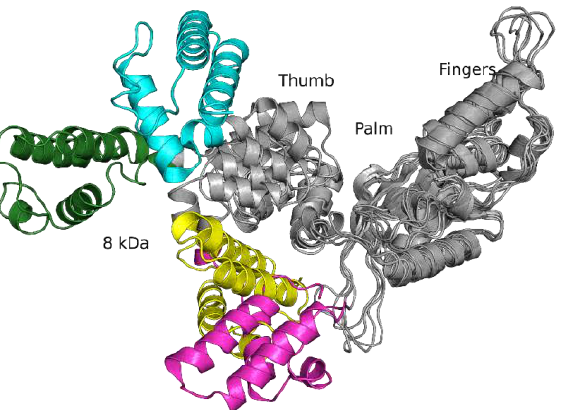
Figure 3. An overlay of rat Pol β apo-enzyme crystal structure 3UXN (cyan) and representative snapshots of unbiased MD simulation for human WT Pol β (green) and its variants G118V (magenta) and R149I (yellow). The parts of mutant variants structure that overlaps with WT rat and human Polβ structure are colored in grey.